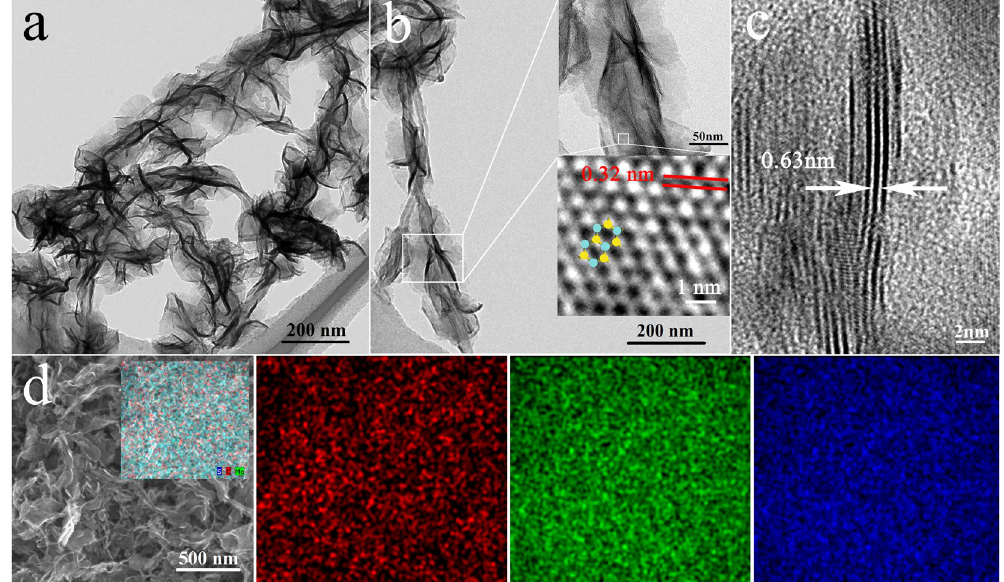
Figure 2. TEM image ( a ) and HRTEM images ( b , c ) of the MoS 2 NS/MWCNT hybrid (the insert graph is a blow-up image of Mo (the yellow dot) and S (the blue dot) atoms and their honeycomb arrangement). ( d ) SEM image and the corresponding EDS elemental mappings of C, Mo, and S for the MoS 2 NS/MWCNT